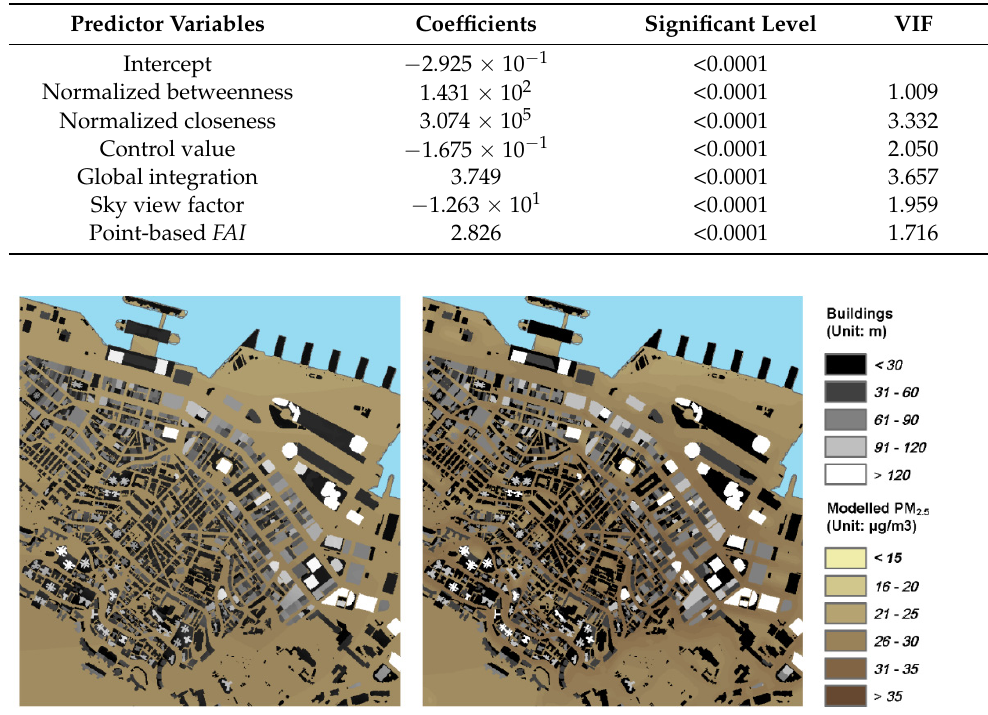
Figure 3. The zoom-in city-scale resulting PM 2.5 map of the downtown area (left) with estimated fine-scale variability in PM 2.5 ( ∆𝑃𝑀 (cid:2870).(cid:2873) ) overlayed (right). Table 3. Summary of the resultant neighborhood-scale regression model.